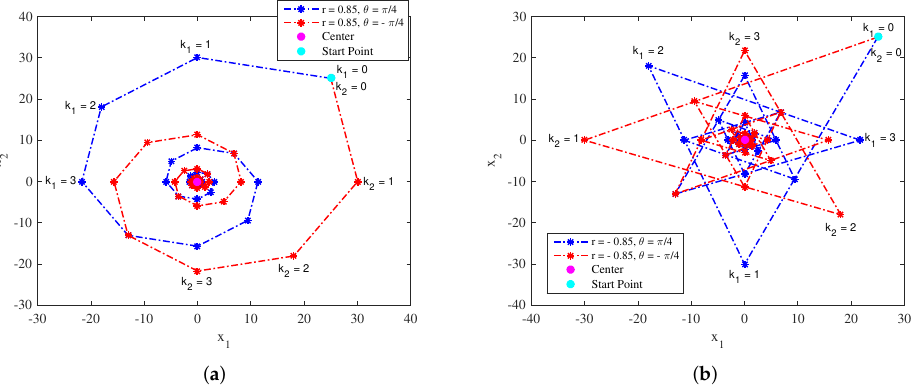
Figure 3. Spiral trajectories for a two-dimensional system for both positive and negative values of θ : ( a ) conventional spiral and ( b ) hypotrochoid spiral.